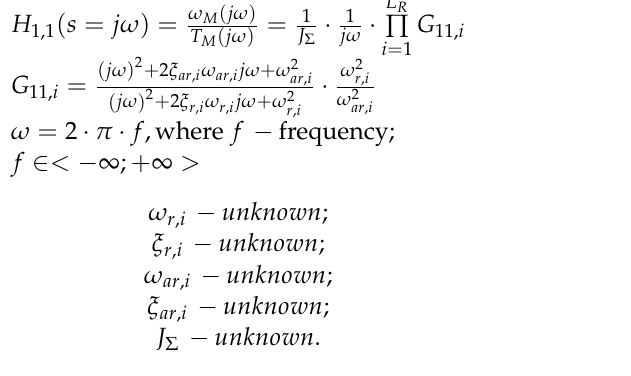
Figure 2. Simulation model of direct drive.